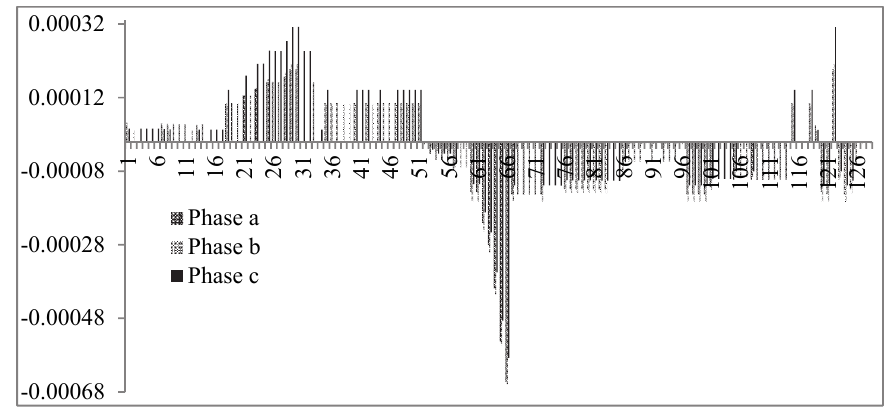
Fig. 5. Voltage difference between runs Q CVRP =70 - Q SP =50 and Q CVRP =80 - Q SP =55 In order to assess the linearized model in terms of the power flow formulation, the maximum voltage difference respect to the non-linearized model (non-linear term for Loss ) is found in Table 6 for both instances. Table 6 Maximum voltage difference between non-linearized and linearized